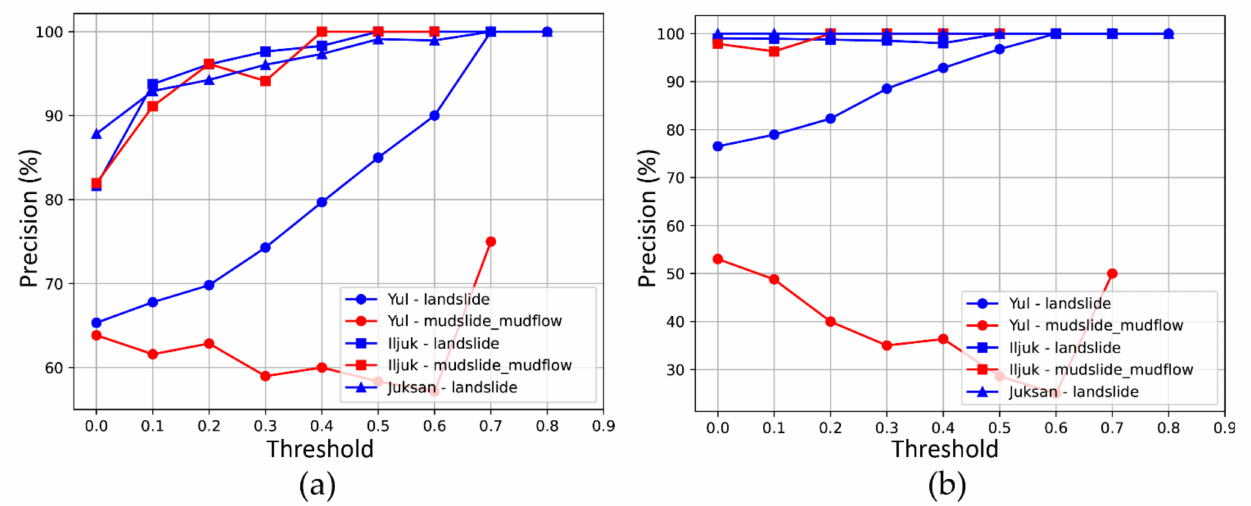
Figure 8. Evaluation of principal image classification using 24–25 August dataset: ( a ) result without hotspot analysis and ( b ) result with hotspot